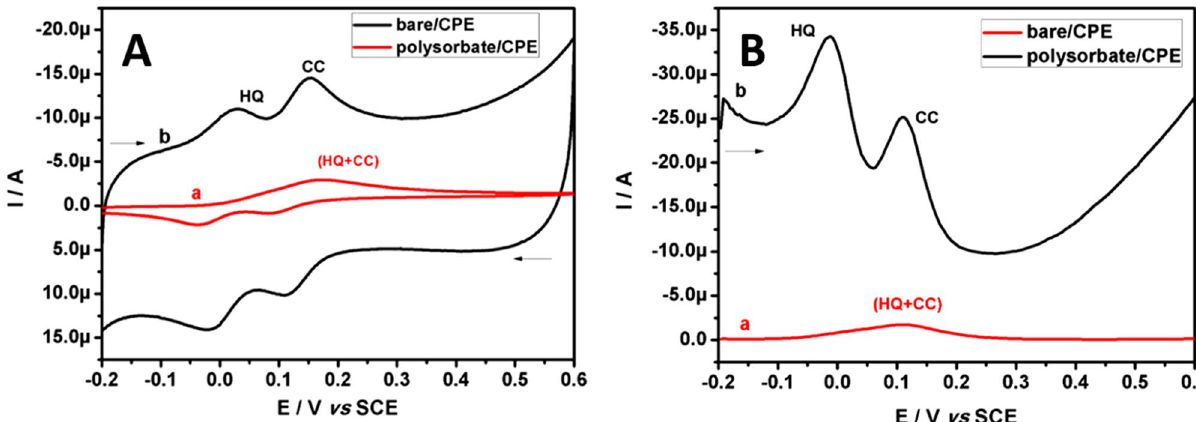
Figure 11. ( A ) CVs recorded for the simultaneous determination of equimolar (10.0 μM) binary mixture of CC and HQ at bare/CPE and polysorbate/CPE in buffer (0.2 M PBS; pH 7.4) with 0.05 Vs −1 scan rate. ( B ) DPVs recorded for the simultaneous determination of equimolar (50.0 μM) binary mixture of CC and HQ at bare/CPE and polysorbate/CPE in buffer (0.2 M PBS; pH